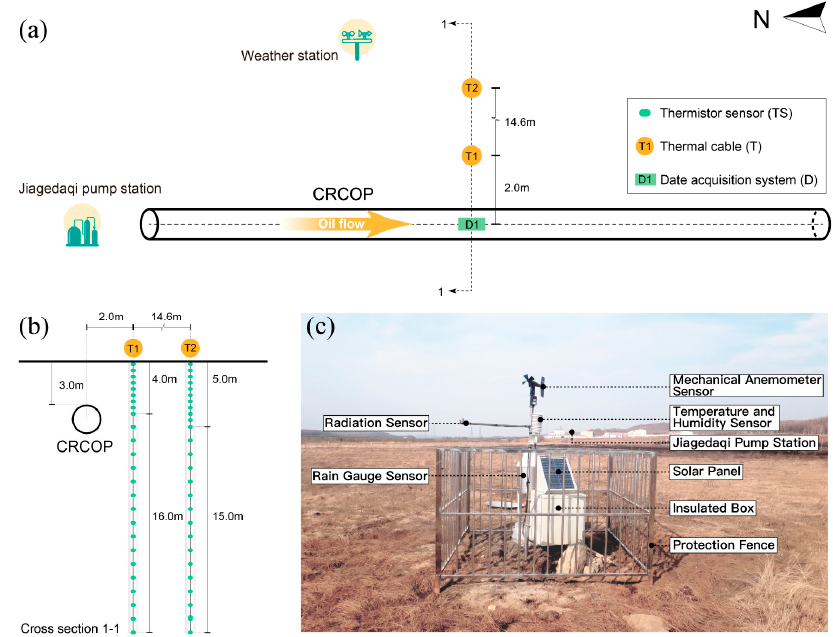
Figure 2. The monitoring system for CRCOP–permafrost interactions. (a) Layout ( b ) Ground temperature sensors in boreholes. ( c ) Small-scale meteorological station layout.